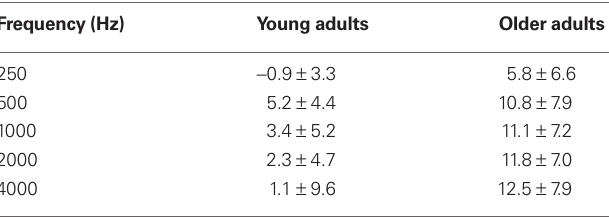
Maxima are from TR3 (6–8 s after trial onset) for location adaptation and TR4 (8–10 s after trial onset) for identity adaptation. BA, Brodmann’s area; X, right/left; Y, anterior/posterior; Z, superior/inferior; BSR, bootstrap ratio; IPL, inferior parietal lobe. Table 4 | Audiometric data for participants in the working memory